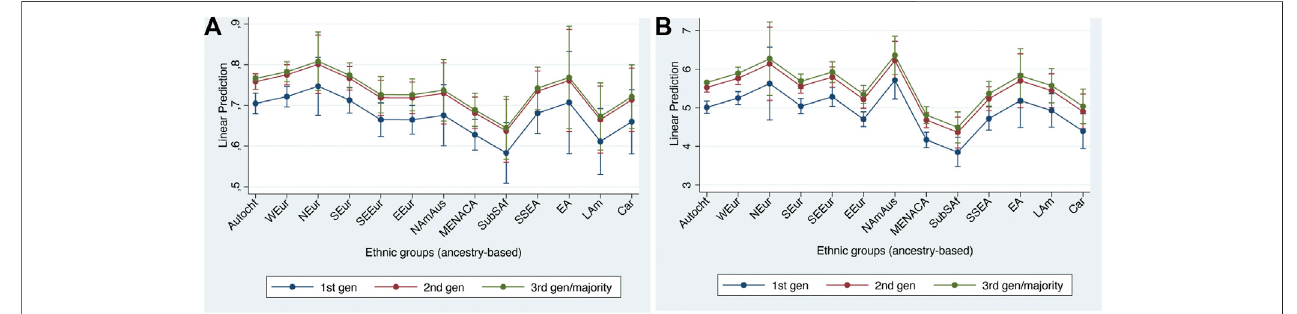
FIGURE 1 | Adjusted predictions at representative values for structural integration indicators with 95% con fi dence intervals. (A) no marginal labor market position; (B) household income